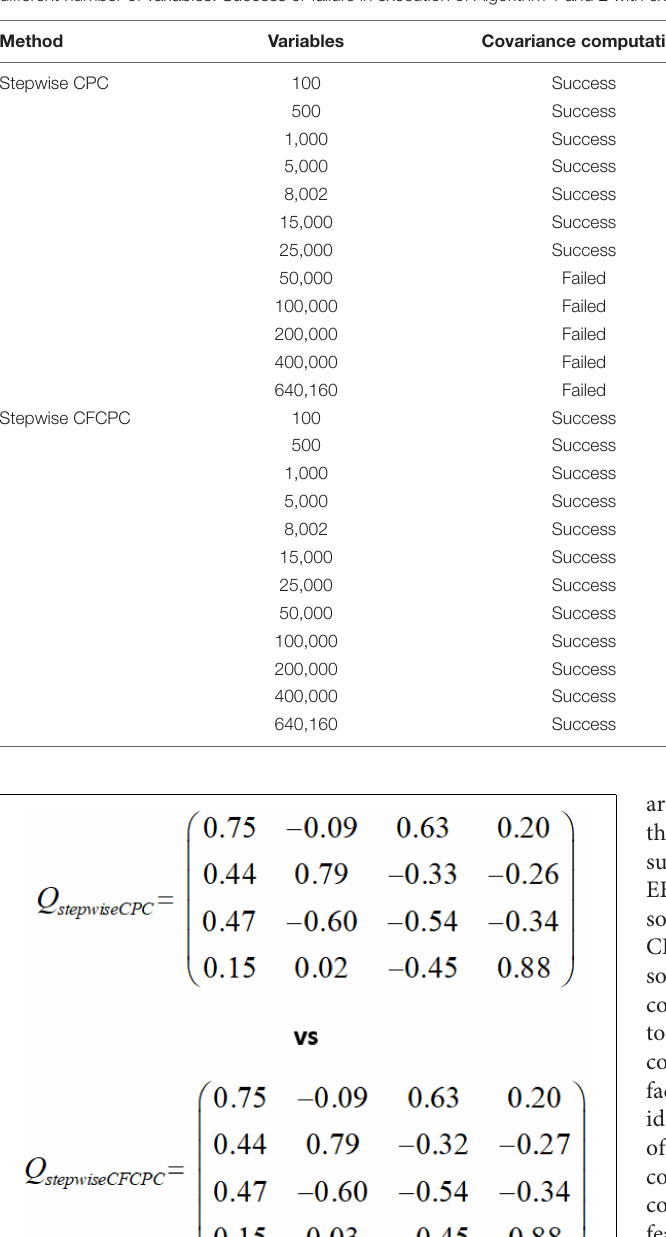
TABLE 1 | Comparison of stepwise CPC and stepwise CFCPC (execution time and memory consumption comparison). Successful computation of covariance for a different number of variables. Success or failure in execution of Algorithm 1 and 2 with execution time for the different number of variables.